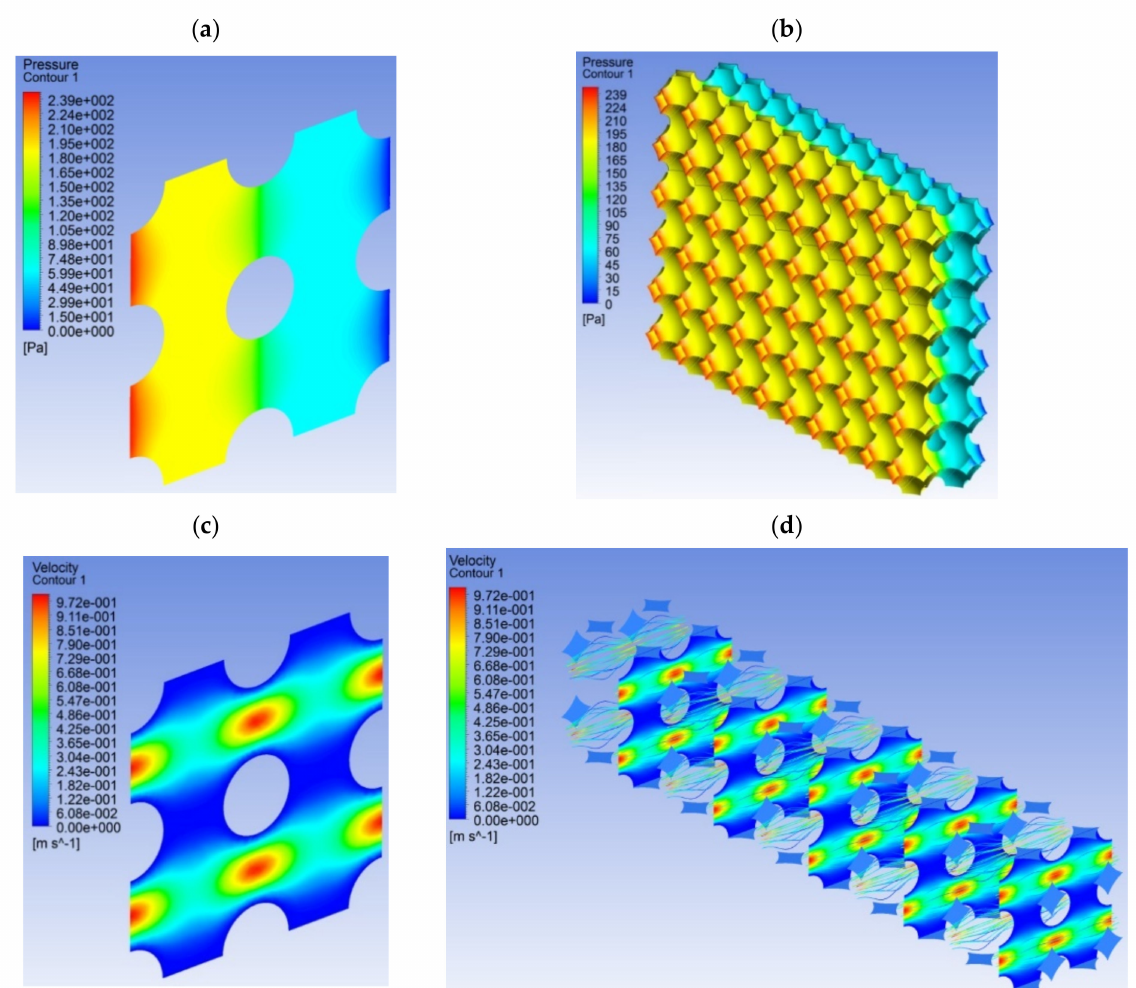
Figure 10. Distribution of gas flow in the framework structure for the cross-section of ( a ) the elementary unit’s pressure, Pa; ( b ) times multiple of the elementary unit’s pressure, Pa; ( c ) the elementary unit’s velocity, ms -1 ; ( d ) times multiple of the elementary unit’s velocity, ms − 1